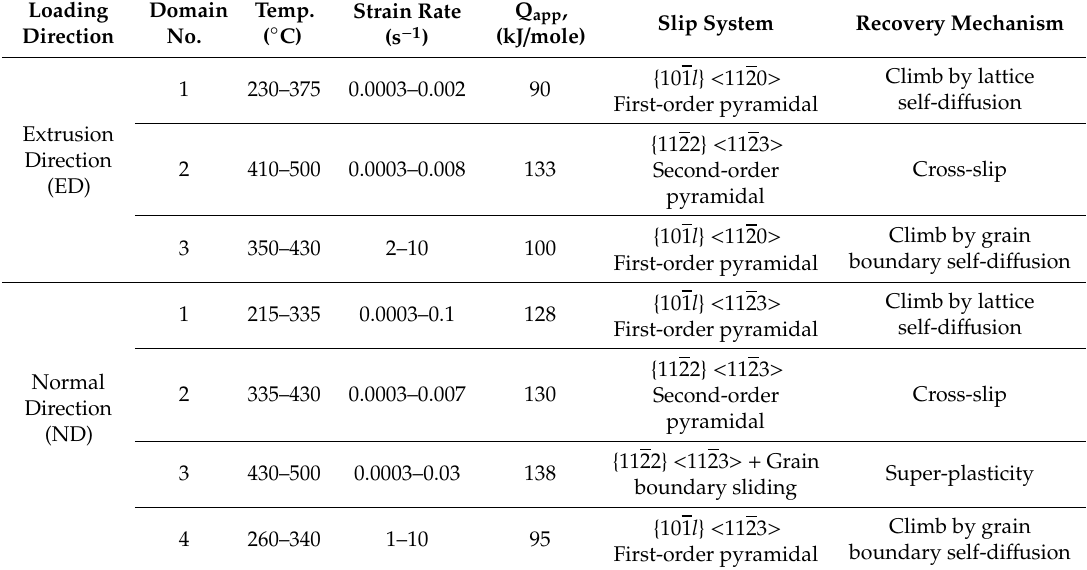
Table 1. The temperature and strain rate ranges, apparent activation energy (Q app ), operating slip systems and recovery mechanisms in the DRX domains exhibited in the processing maps of ZK60A-T5 alloy compressed along ED (Figure 4a) and ND (Figure